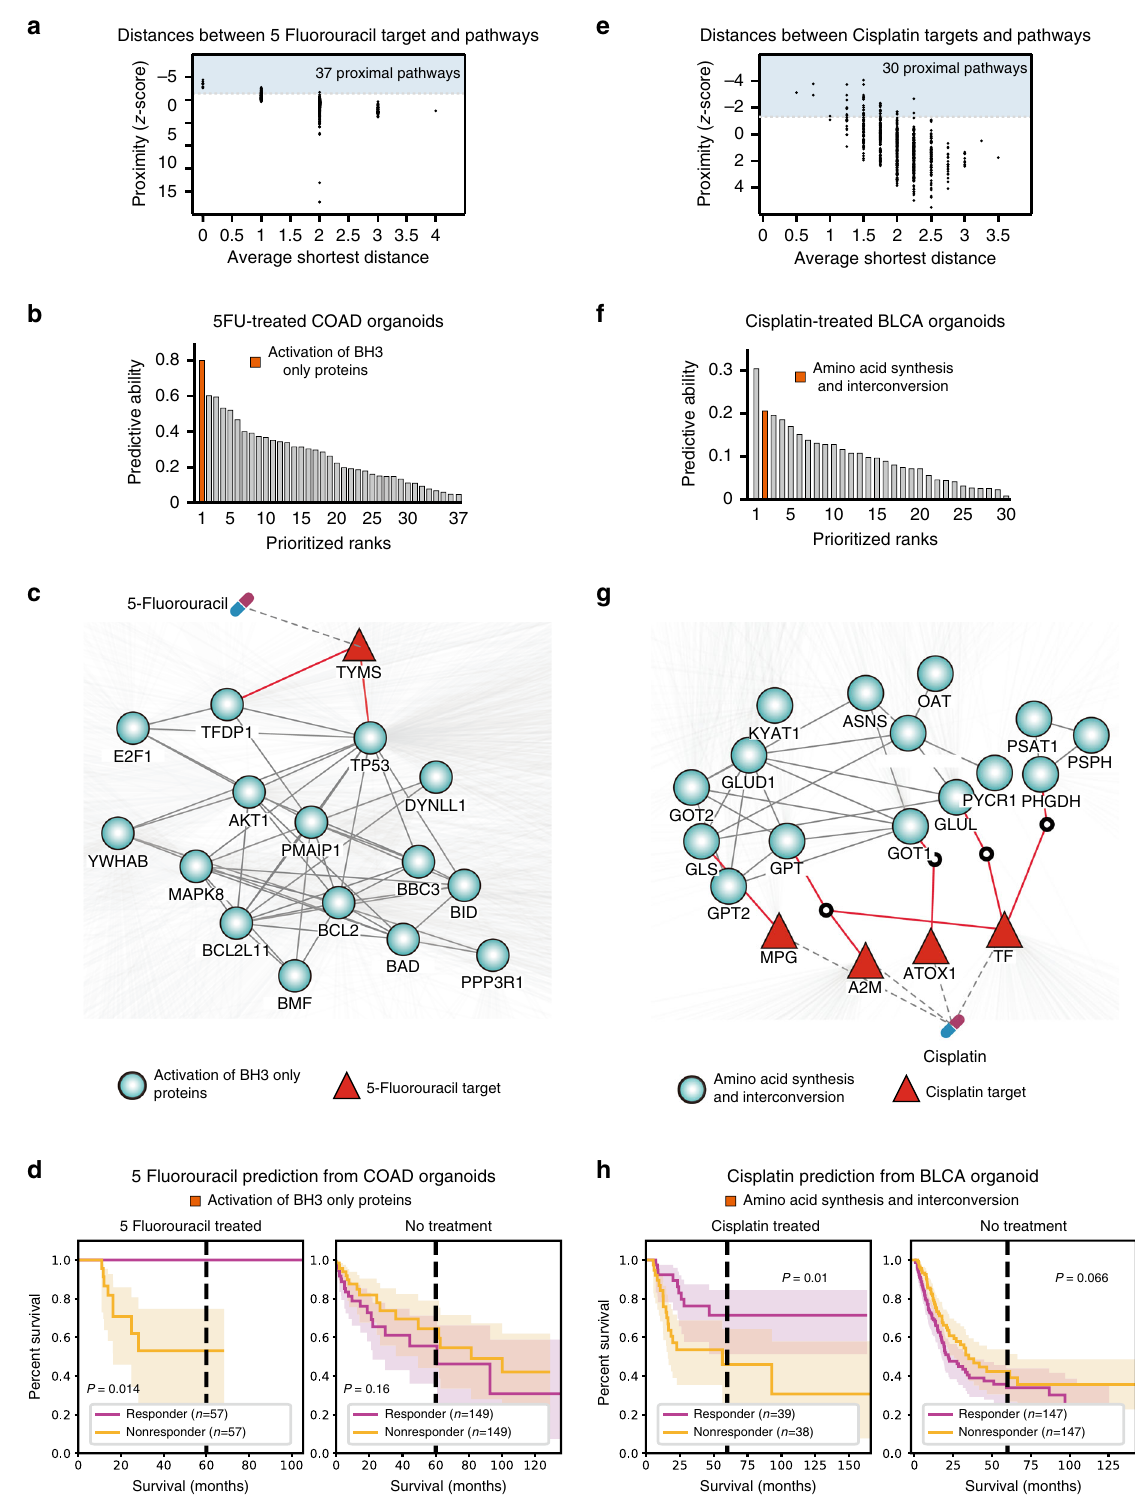
Predictive ability of no feature selection models, alternative feature selection models, and a deep-learning model . To demonstrate the utility of our method, we fi rst tested the per- formance of drug-response prediction without a feature selection process (Fig. 3a – c). We found that the application of ridge regression models on whole-genome or whole-pathway tran- scriptomic data from 3D organoid models was not predictive